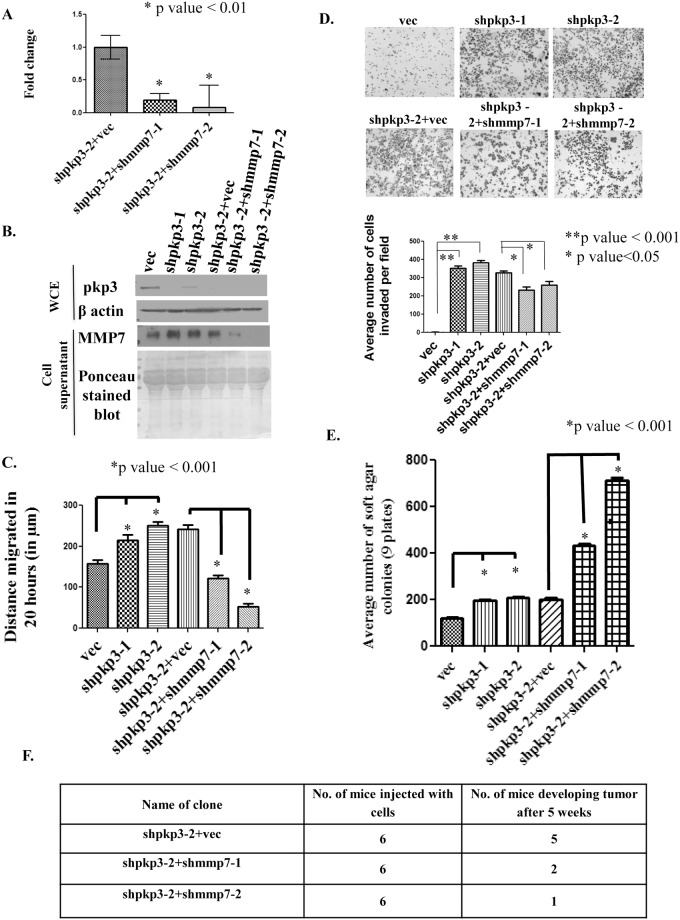
Loss of MMP7 leads to a decrease in transformation in cells lacking PKP3.
(A) mRNA prepared from HCT116 derived PKP3 knockdown cells transfected with the vector control (shpkp3-2 + vec) or the MMP7 knockdown construct (shpkp3-2 + shMMP7-1 and shpkp3-2 + MMP7-2) was used as a substrate for reverse transcriptase followed by real time PCR reactions using oligonucleotides specific for MMP7. All expression was normalized to the levels of GAPDH. The fold change is graphed on the Y-axis and the clone name is on the X-axis. Note that MMP7 levels are lowered in the double knockdown clones as compared to the vector control. The standard errors are plotted and student’s t test was performed (* indicates a p value <0.01). (B) 75μg of a whole cell extract (WCE) was resolved on 12% SDS PAGE gels followed by Western blotting with antibodies specific to PKP3. Note that PKP3 levels are lower in clones with a PKP3 knockdown. Western blots for β actin served as a loading control (upper panels). 100μg of acetone precipitated cell supernatants were resolved on 12% SDS PAGE gels followed by Western blotting with antibodies specific to MMP7. Note that MMP7 levels are higher in supernatants prepared from the PKP3 knockdown cells as compared to the vector controls and the levels are lower in the double knockdown clones. The same blot was stained with Ponceau stain to demonstrate equal loading of proteins (lower panels). (C) Scratch wound healing assays were performed on the HCT116 derived vector control (vec), PKP3 knockdown clones (shpkp3-1 and shpkp3-2), shpkp3-2 derived vector control clone (shpkp3-2+vec) and shpkp3-2 derived MMP7 knockdown clones (shpkp3-2+shMMP7-1 and shpkp3-2+shMMP7-2) as described. (D) Matrigel invasion assays were performed in Boyden’s chambers for HCT116 derived vector control cells, PKP3 knockdown clones and the double knockdown clones. The number of cells observed in ten random fields of the membrane for each clone was determined as described in Materials and Methods, representative images of for each clone are shown. The mean and standard deviation of three independent experiments are plotted. Note that loss of PKP3 leads to an increase in invasion as compared to the vector control and this phenotype is reversed in the double knockdown clones. (E) Soft agar colony formation assay was performed with the HCT116 derived vector control and pkp3 knockdown clones, the shpkp3-2 derived double knockdown clones and the shpkp3-2 derived vector control clone. The mean and standard deviation of three independent experiments is plotted. (F) 1x106 cells of the shpkp3-2 derived vector control or double knockdown clones were injected sub-cutaneously into nude mice and allowed to develop tumors. The table shows the number of mice injected with the respective clones and the number of mice among them which were able to develop tumors. Wherever indicated the p value was calculated using a student’s t-test.